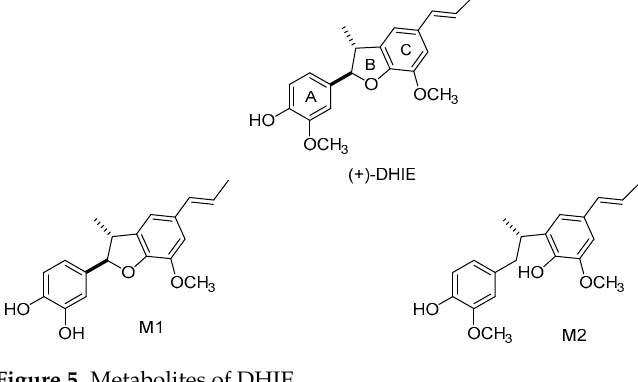
Figure 5. Metabolites of DHIE.